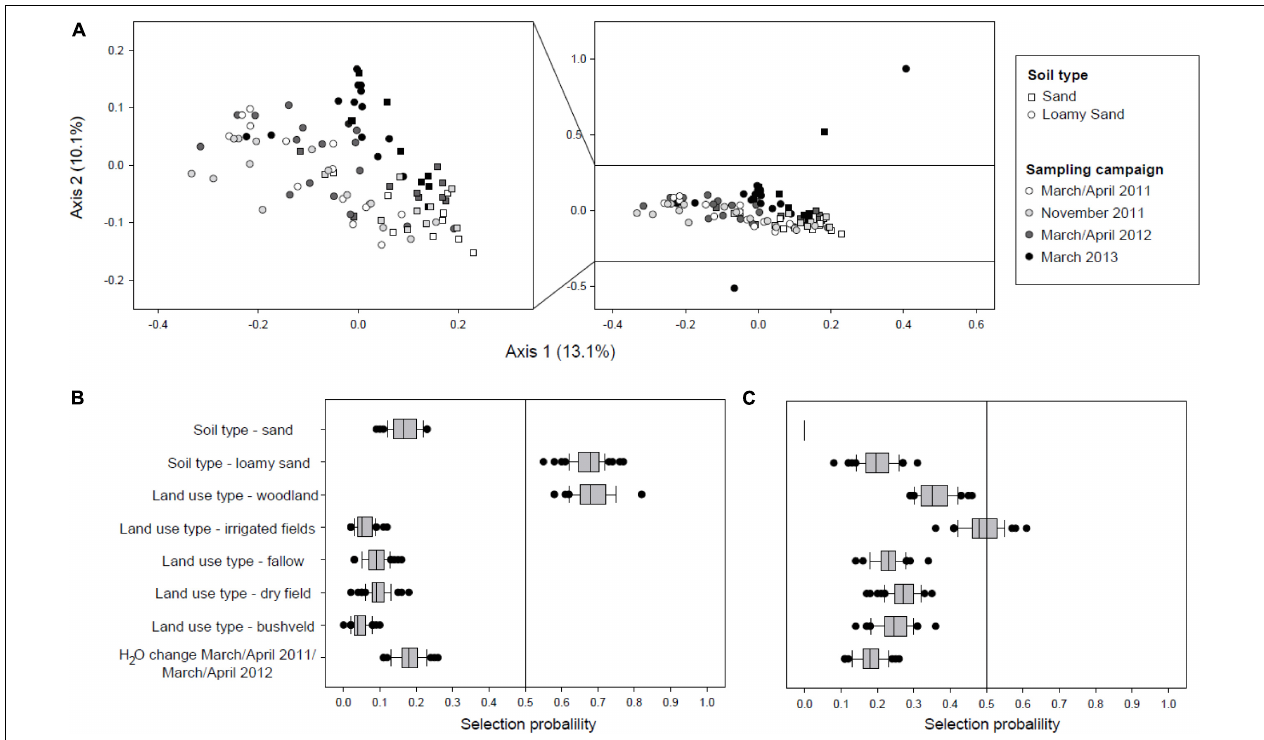
FIGURE 4 | (A) β -diversity active acidobacterial communities over 2 year observation period as determined by PCoA of weighted-unifrac distances. For better resolution, the central portion of the ordination plot without three outliers is enlarged on the left. PERMANOVA tests indicated that the changes between the different time points were significant ( p = 0.001–0.05). (B) Variable selection of explanatory environmental variables of Procrustes residuals for the first dry/wet season cycle. (C) Variable selection of explanatory environmental variables of Procrustes residuals for the second dry/wet season cycle with severe